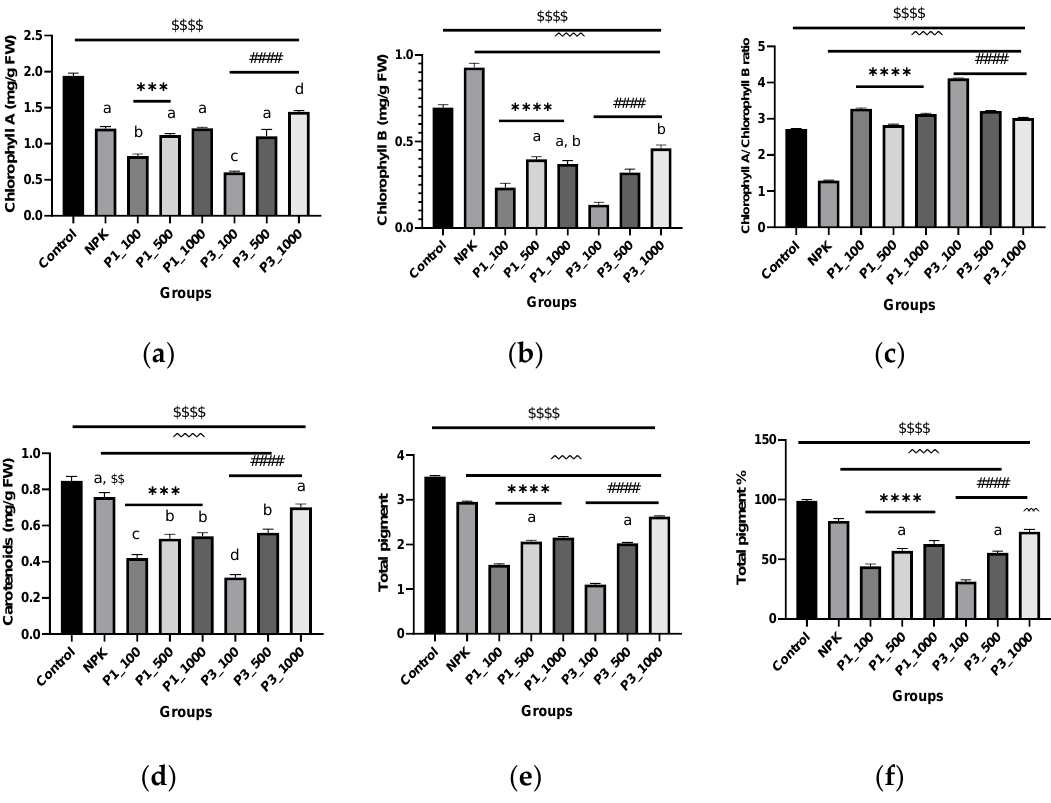
Figure 5. Photosynthetic pigments analysis: chlorophyll A content ( a ), chlorophyll B ( b ), chlorophyll A/chlorophyll B ratio ( c ), carotenoids content ( d ), total pigment ( e ), and percentage of the total pig- ment ( f ) in different groups. Results are expressed as mean ± SE, $ (dollar sign) significant difference with negative control at p < 0.0001, # (number sign) statistically compared P3 groups with the P3_100. ^ (circumflex accent) statistically compared with NPK. Different letters refer to statistically significant differences between groups at p ≤ 0.001, while the same letters refer to non -significant (ns) difference between groups at p ≤ 0.05, using one - way ANOVA followed by Tukey’s test. **** indicates p ≤ 0.000 1, ***, indicates p ≤ 0.001 (that was applied to the other signs). P1 = nHAPs_PPE; P3 = nHAPs_CE.